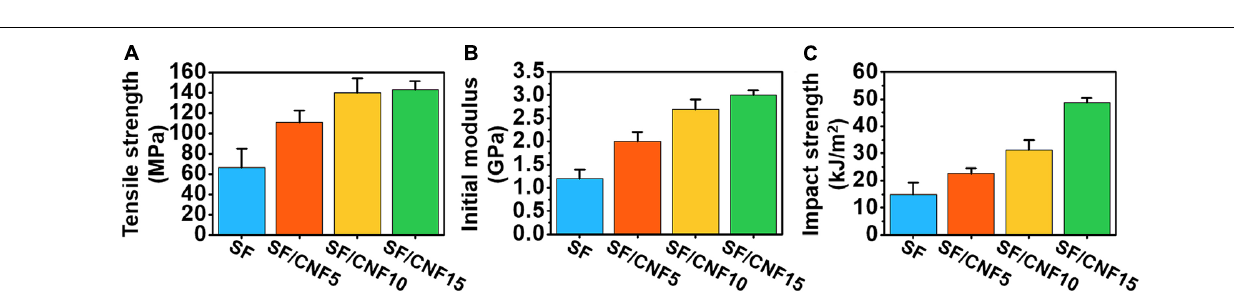
Frontiers in Materials |